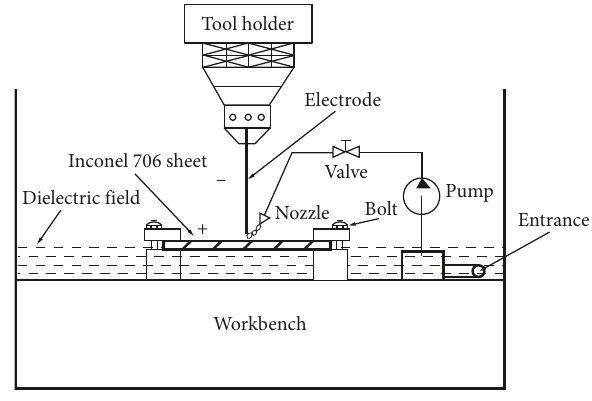
Figure 2: Diagram of EDM. Table 1: Nominal chemical composition of the as-received Inconel 706